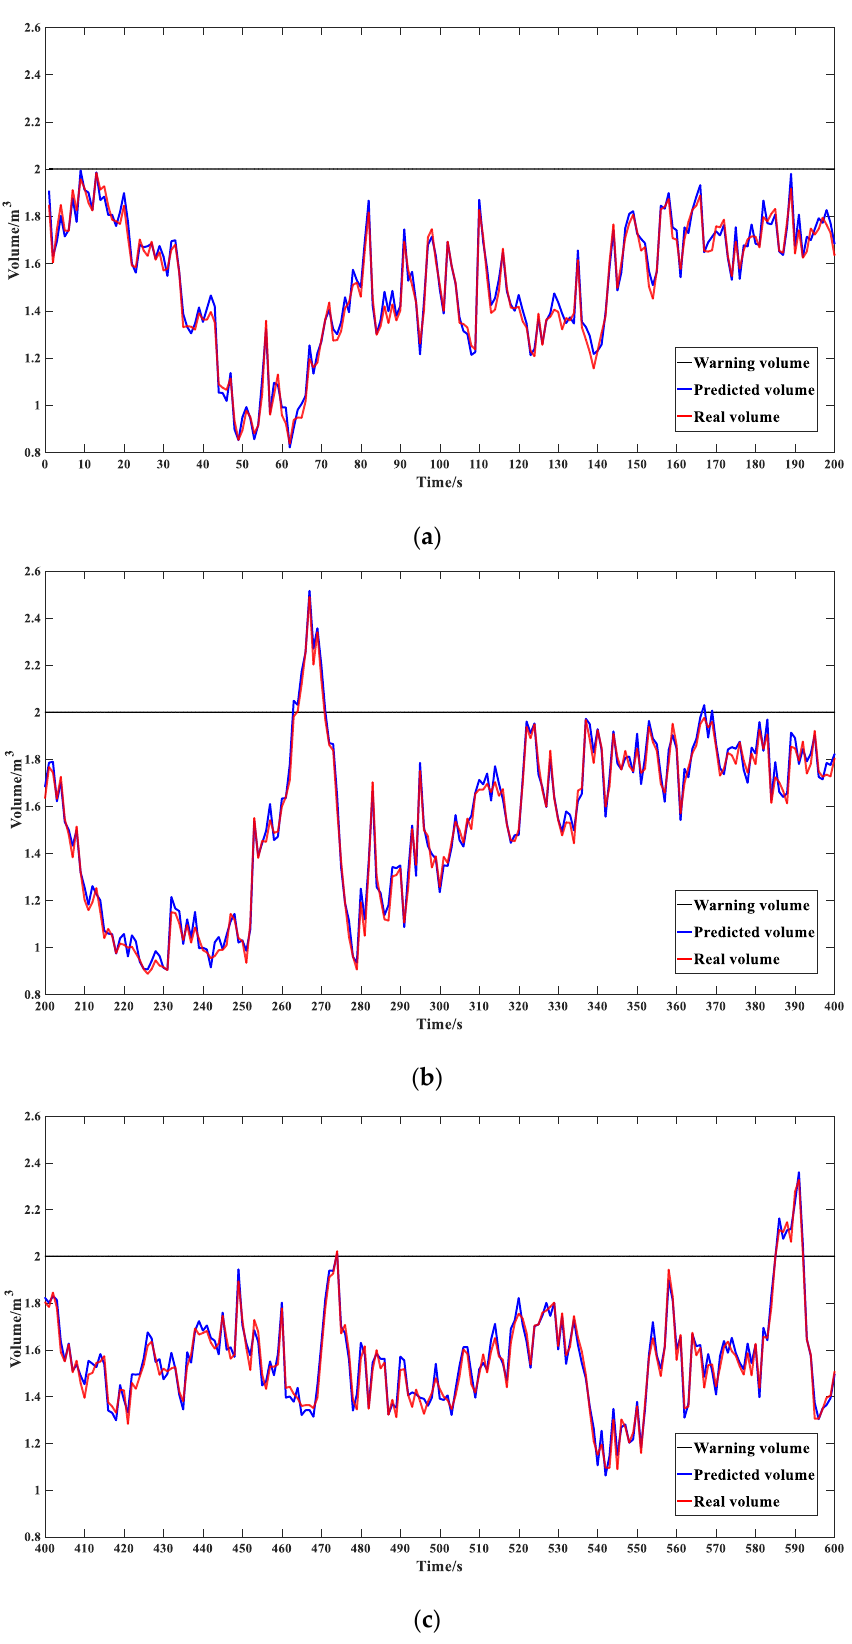
Figure 14. Scraper conveyor flow monitoring diagram: ( a ) Time interval (0~200); ( b ) Time interval (200~400); ( c ) Time interval (400~600).